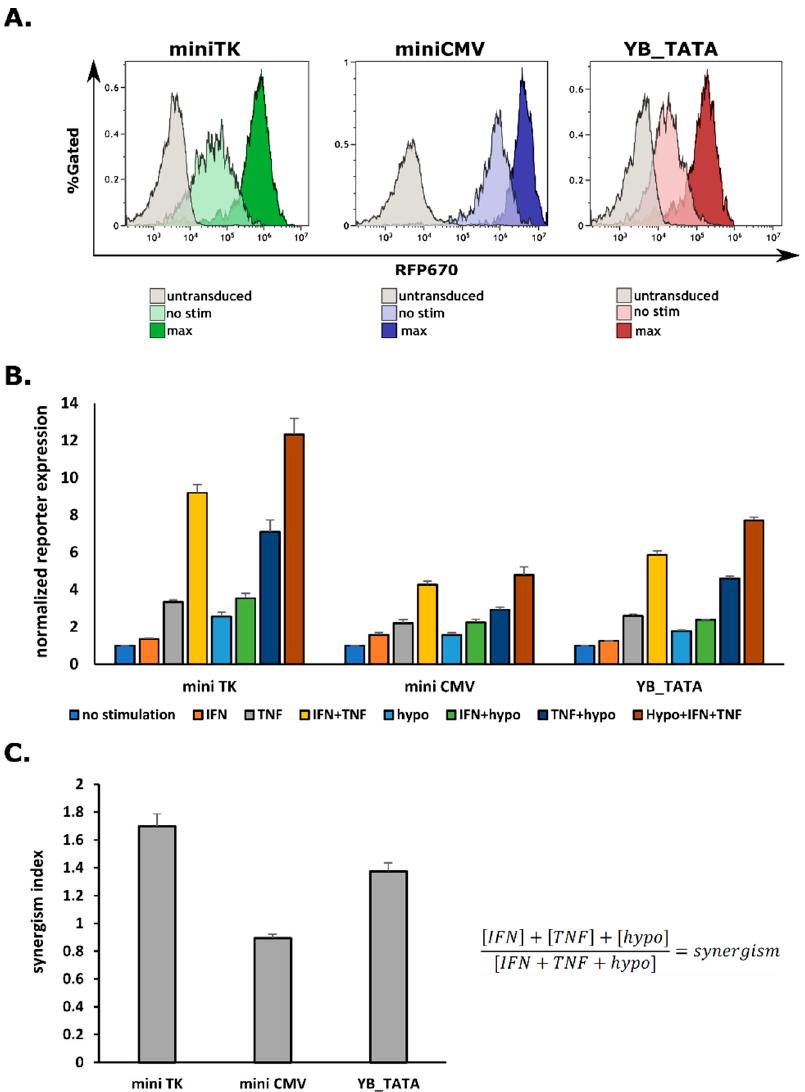
Figure 2. All three minimal promoters are functional when combined with the G1K0.6H1 CARTIV response element: HEK293T cells were infected using lentiviral vectors with RFP670 under the control of the indicated minimal promoter combined with the G1K0.6H1 CARTIV PRE and a ZsGreen reporter controlled by the ef1 α core promoter. Data shown are ZsGreen-positive, single-discriminated, and DAPI-negative results. ( A ) Representative FACS plots of the indicated promoter’s background expression and maximum induction. ( B ) Reporter expression fold change geometric mean (gmean) average of triplicates from the ZsGreen positive fraction; error bars indicate standard deviation. ( C ) Synergism index of for the tested promoters and the formula used to calculate it.